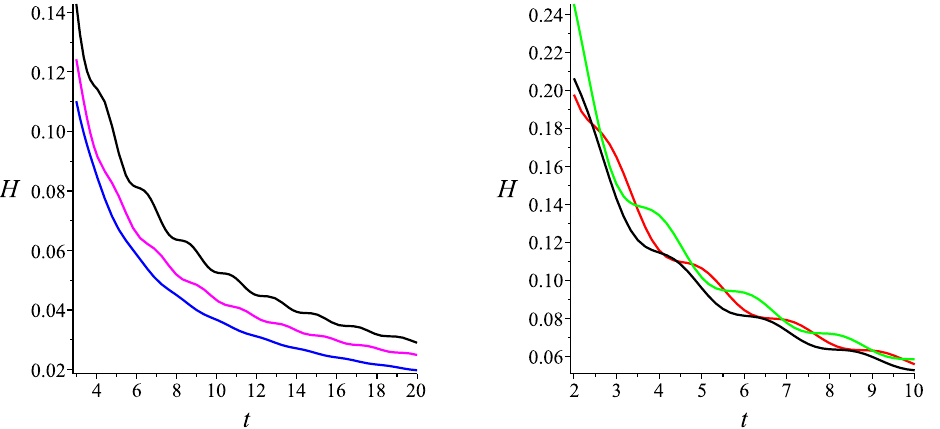
Figure 12 . The trajectories dot at one end of a trajectory denotes its starting point at t = 0.